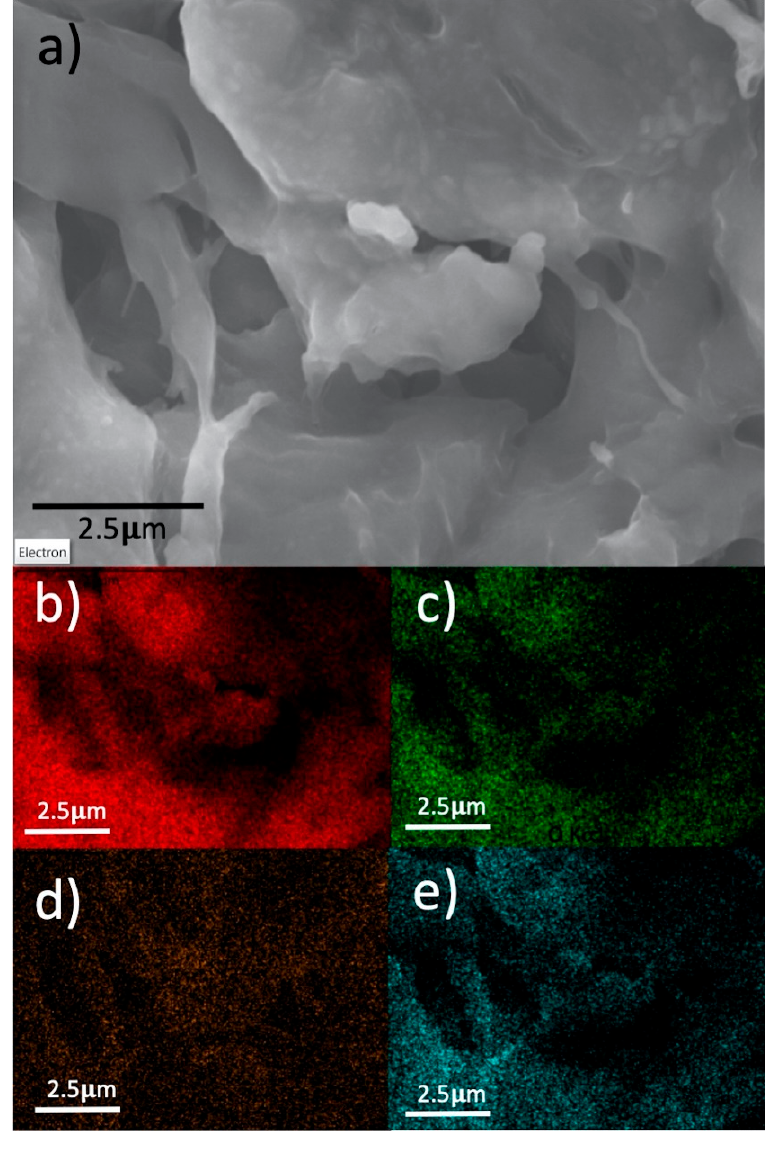
Figure 3. Representative SEM image of PAN-N/3%Co sample ( a ), and its corresponding SEM-EDX mapping for the following elements: carbon ( b ), nitrogen ( c ), cobalt ( d ), and Oxygen ( e ).